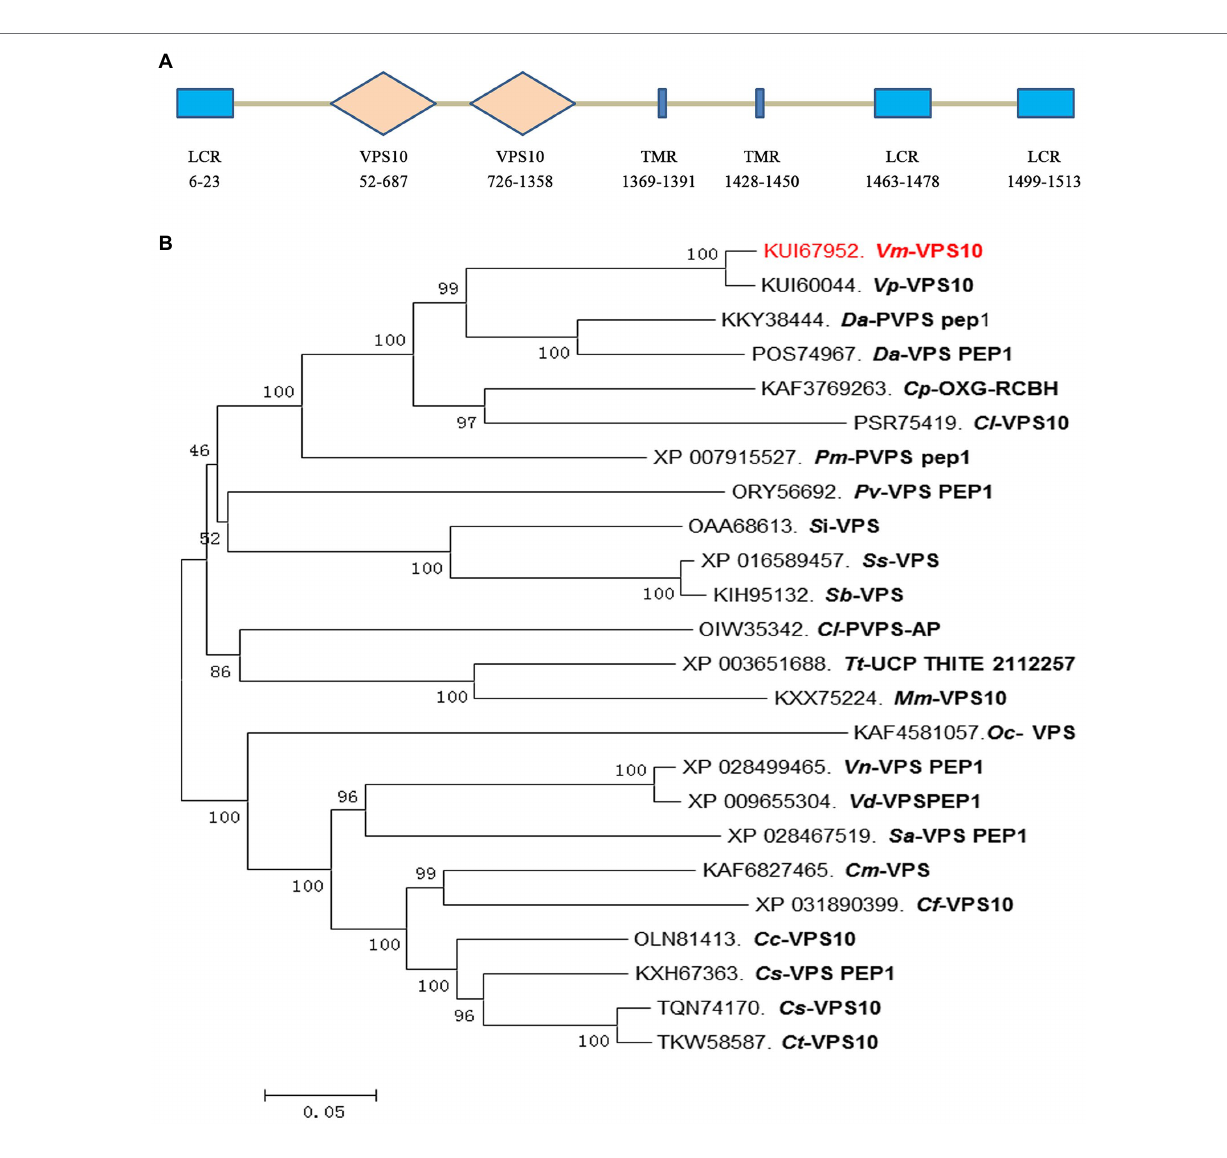
FIGURE 4 | Protein sequence characterization and phylogeny analysis of the Vm - VPS10 . (A) The typical domains of Vm - VPS10 . Vm - VPS10 contains three conserved domains, including low complexity region (LCR), VPS10 , and transmembrane region (TMR). VPS10 is the core domain, which is a receptor domain, and TMR is an important transmembrane helix region. The numbers below the structure indicate the amino acid sites of each domain. (B) The phylogenetic tree was constructed with neighbor-joining method using MEGA 6. Bootstrap values were set as 1,000. Vm - VPS10 is highlighted in red. Vm , Valsa mali; Vp, Valsa pyri; Da, Diaporthe ampelina; Dh, Diaporthe helianthi; Cp, Cryphonectria parasitica; Cl, Coniella lustricola; Pm, Phaeoacremonium minimum; Pv, Pseudomassariella vexata; Si, Sporothrix insectorum; Sc, Sporothrix schenckii; Sb, Sporothrix brasiliensis; Tt, Thermothielavioides terrestris; Mm, Madurella mycetomatis; Oc, Ophiocordyceps camponoti-floridani; Vn, Verticillium nonalfalfae; Sa, Sodiomyces alkalinus; Cm, Colletotrichum musicola; Cf, Colletotrichum fructicola; Cc, Colletotrichum chlorophyte; Cs, Colletotrichum salicis; and Ct, Colletotrichum